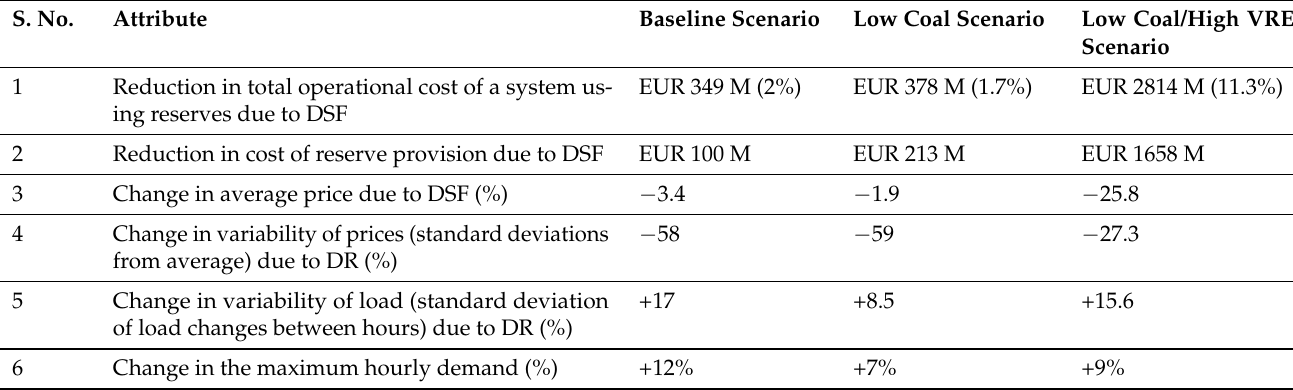
Table 4. Summary of impacts of DSF on a system with